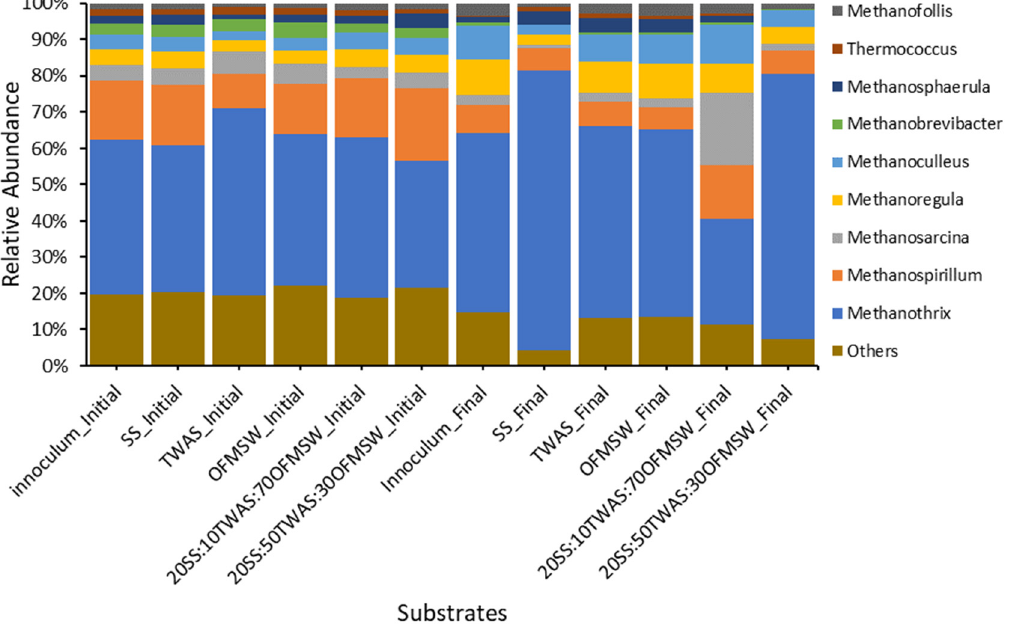
Figure 4. The relative abundances of the top 10 most prevalent genera in Euryarchaeota in both the initial and final phases of this initial and final phases of this study .